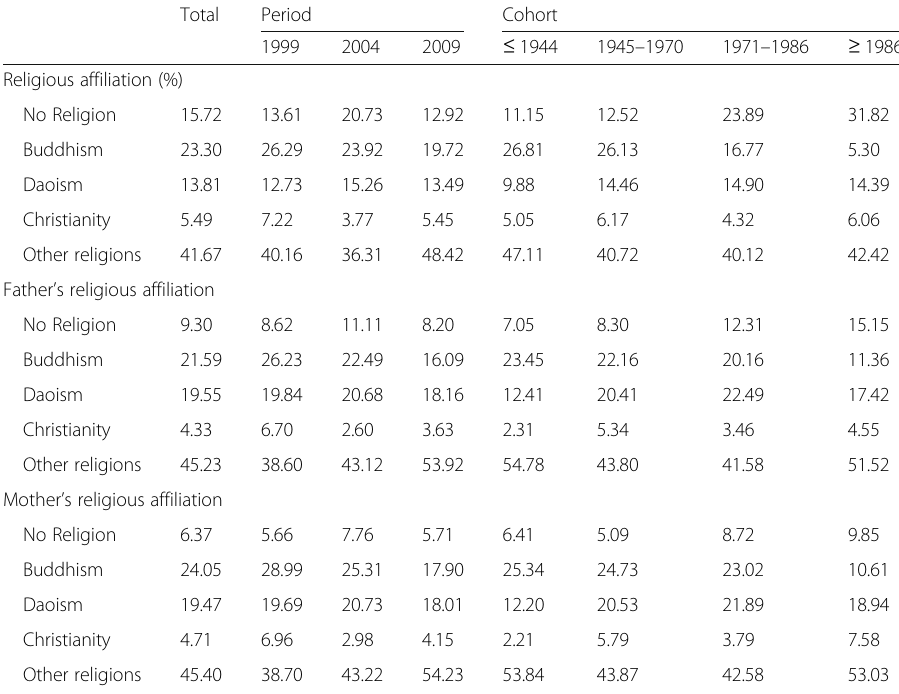
Table 2 Membership by denomination, period, and cohort Total Period